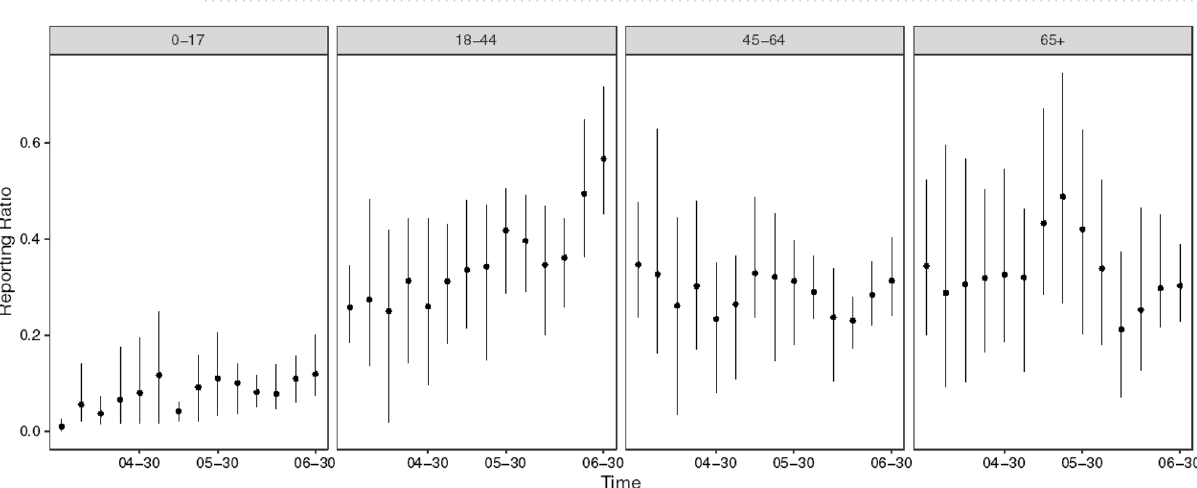
Figure 3. Weekly ratio between inferred reported cases and total cases for different age